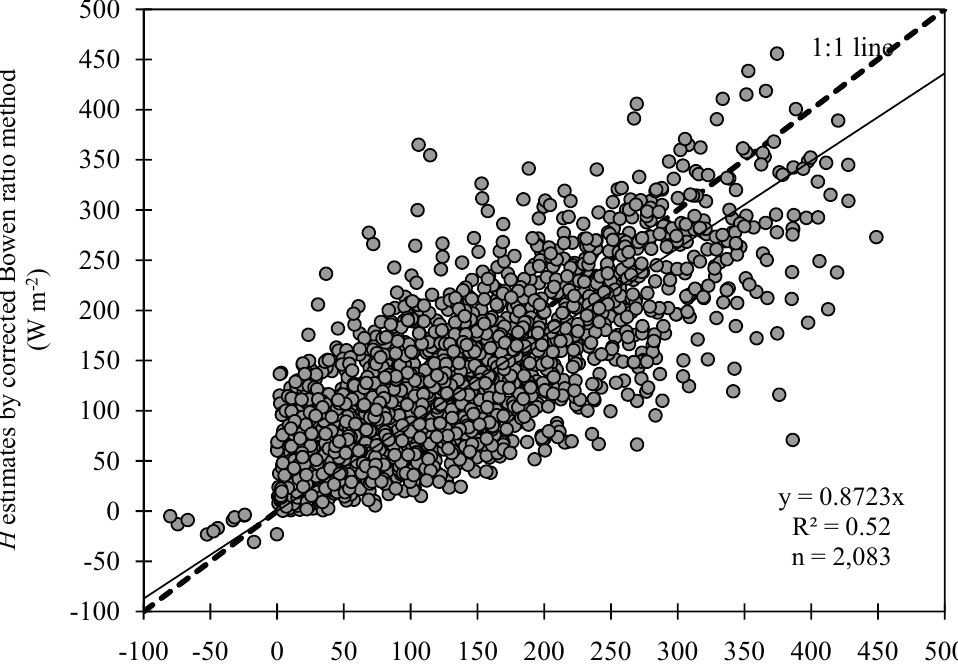
H estimates by eddy covariance method (W·m -2